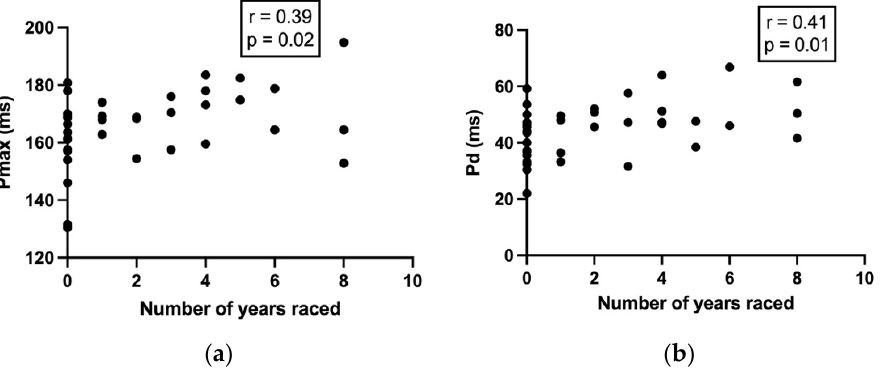
Figure 2. Relationship between exercise duration (number of years raced) and ( a ) Pmax and ( b ) Pd.